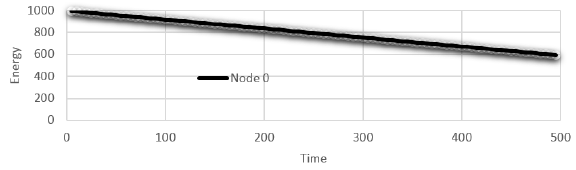
Figure 6. Energy Depletion and Transmission Power of Scenario 1a .